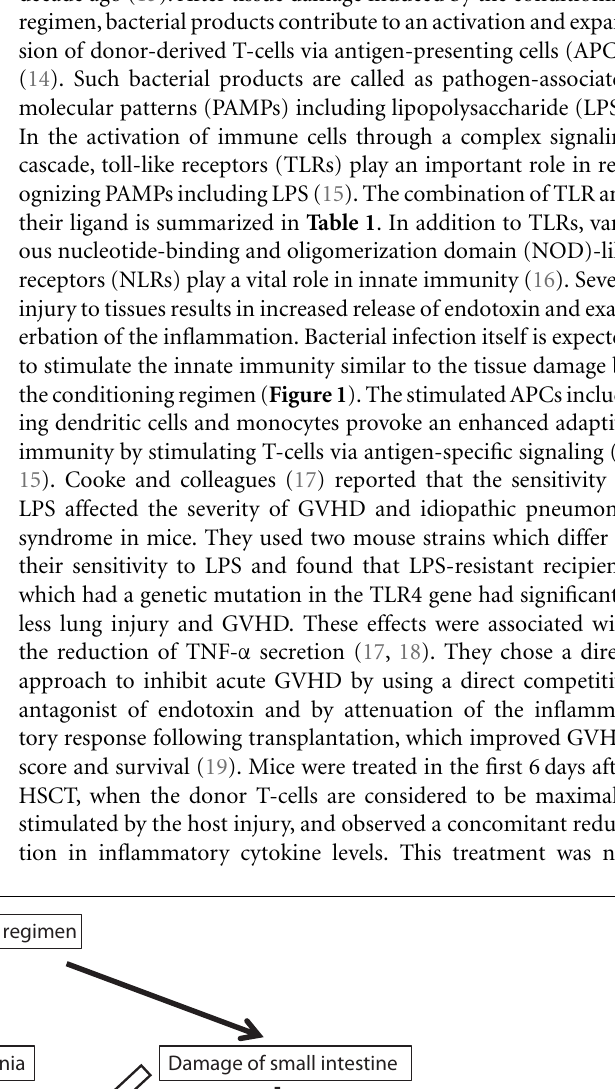
FIGURE 1 | Possible implication of bacterial infection in the pathogenesis of GVHD . Progression of acute GVHD can be summarized in three steps following the damage of host tissue by conditioning regimen: (1) activation of APCs; (2) donorT-cell activation, proliferation, differentiation, and migration; and (3) target tissue destruction. Injury to the gastrointestinal tract from conditioning causes systemic translocation of additional inflammatory stimuli,